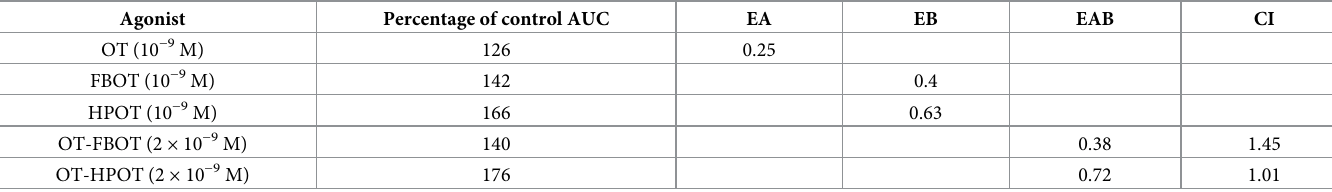
Experiments on virgin mouse uterus showed that FBOT possesses strong agonistic effects, confirming its superagonist function in OT receptor-overexpressing HEK-293 cells [7]. In sharp contrast, HPOT showed the lowest EC value among the four agonists tested in the 50 same mouse tissue, while HPOT was the most potent agonist in human tissue. The reason for this discrepancy is unclear. This may be because of species-specific differences and differences between non-pregnant and pregnant tissues. Therefore, the effects of HPOT have to be assessed in the pregnant uterus or uterine muscles during parturition in mouse mothers. In the current research, we limited our study only by the inclusion of virgin mice in order to